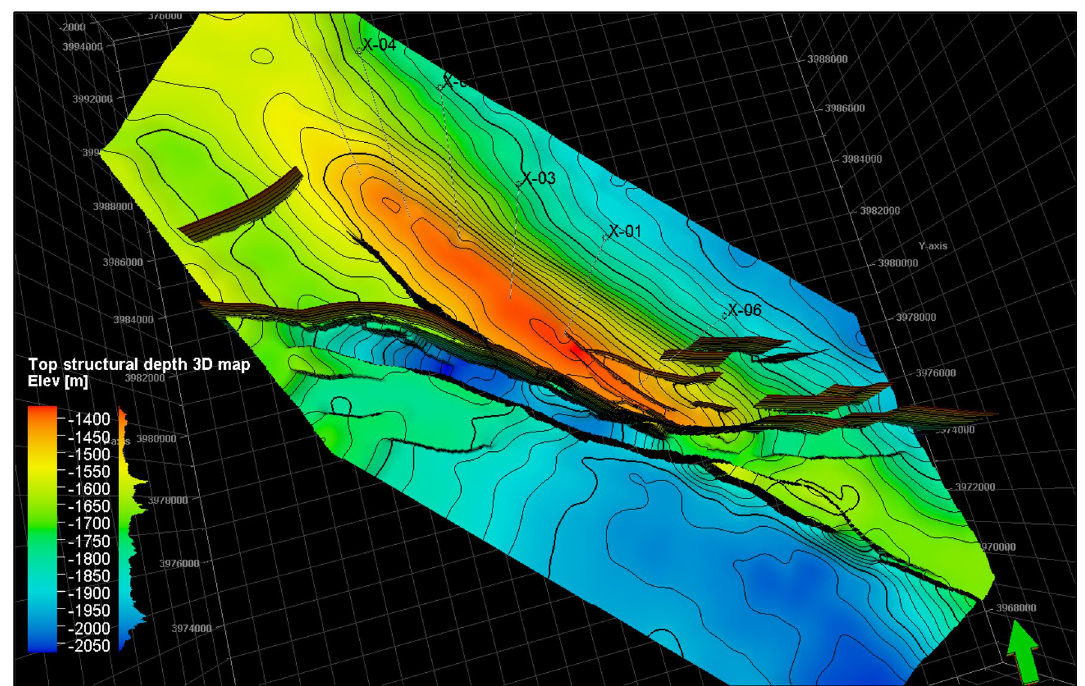
Fig. 1 Top structural depth 3D map and fault network